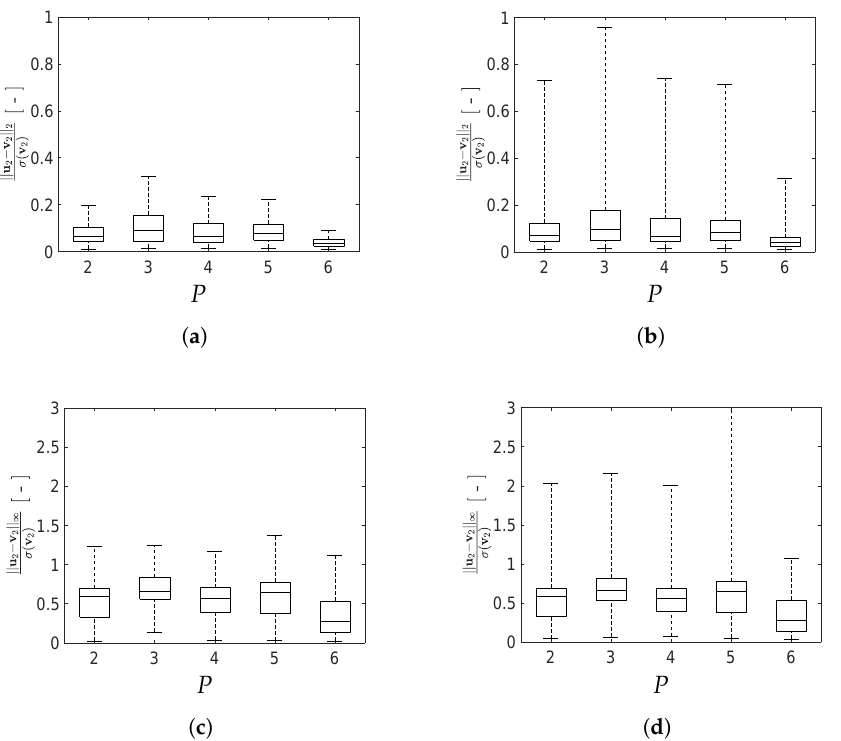
Figure 17. Two-storey shear building, configuration B. Effect of P on the statistics of the reconstruction errors relevant to the floor displacement v 2 , represented through box plots: ( top row ) standardized L 2 norm, and ( bottom row ) standardized L ∞ norm; data taken from ( left column ) training set, and ( right column ) test set.